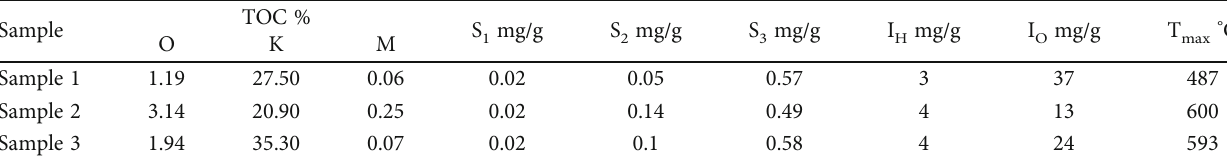
Figure 1: Sample collection point ((a) planogeologic map; (b) lithology histogram). Table 1: Organic geochemical characteristics of the